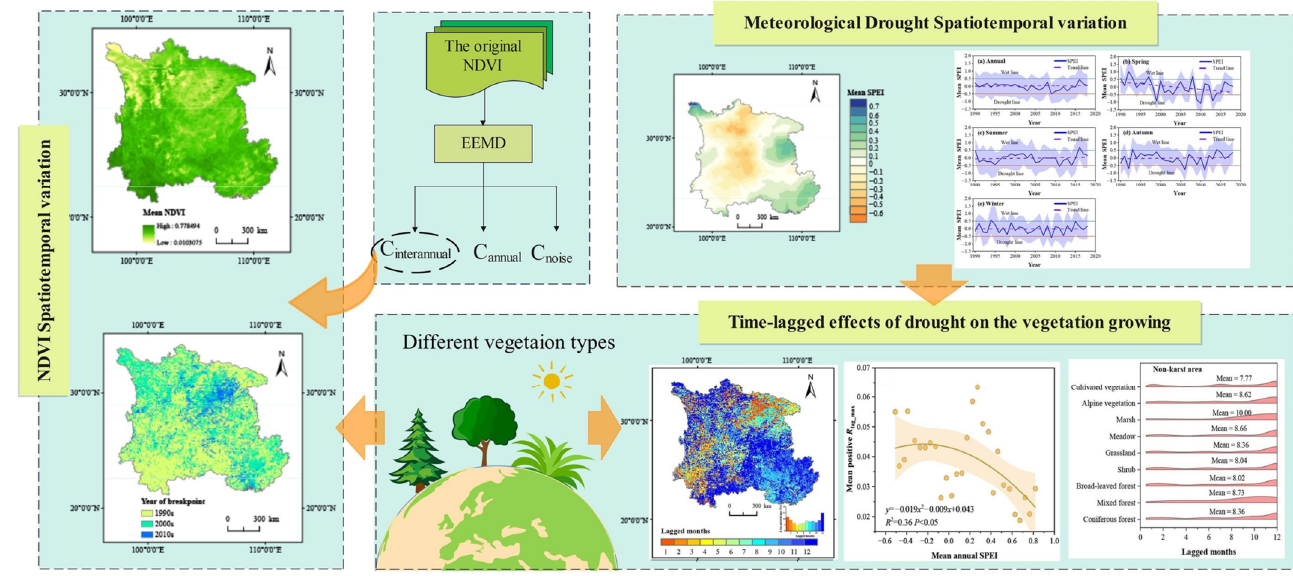
Figure 3. Overall framework for this study.